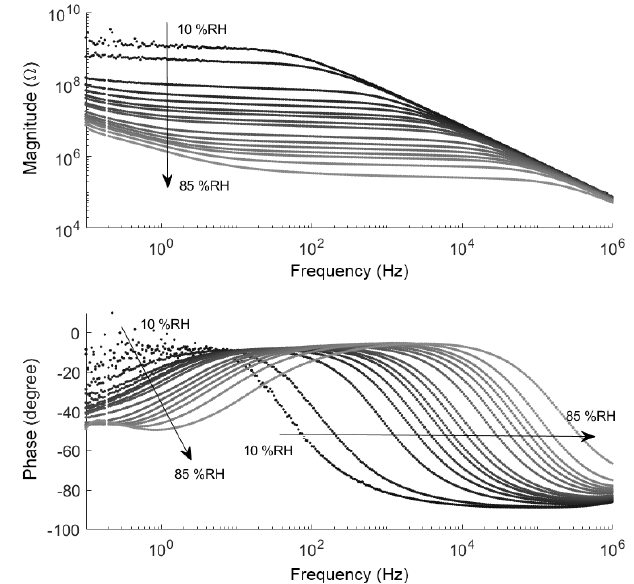
Figure 5. Bode diagram of the sensor at different relative humid- ity levels at elevated temperature. The colored dots represent the experimental data to which the model was fitted (colored